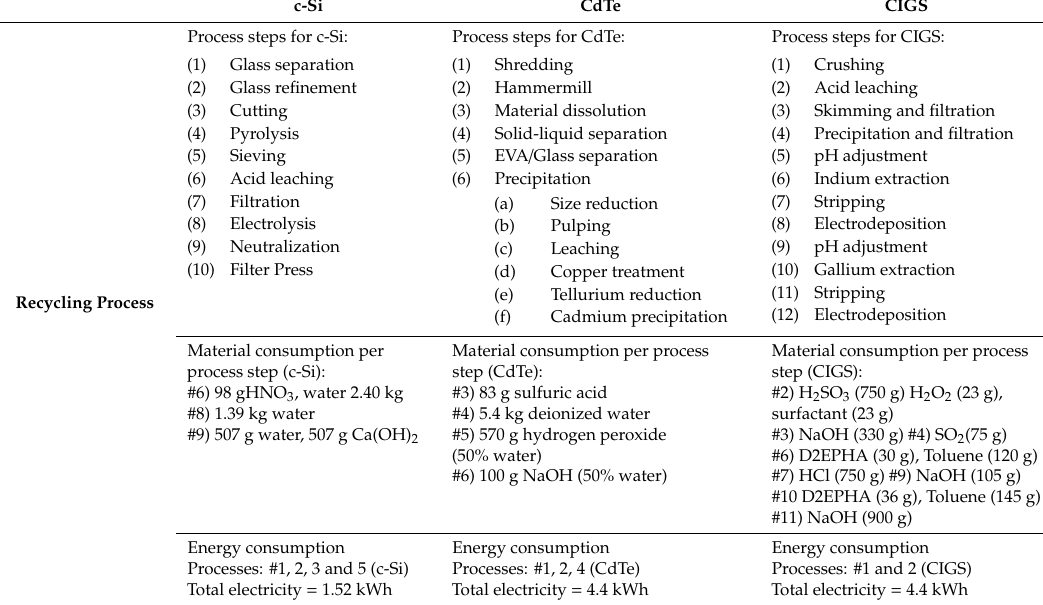
Table 1. The comparison of the inventories for recycling of di ff erent photovoltaic (PV) modules (1 m 2 of PV panel). c-Si and CdTe recycling incorporate mechanical and chemical based methods while CIGS mostly involves chemical based methods. Transportation is consistent for the technologies, equal to 1000